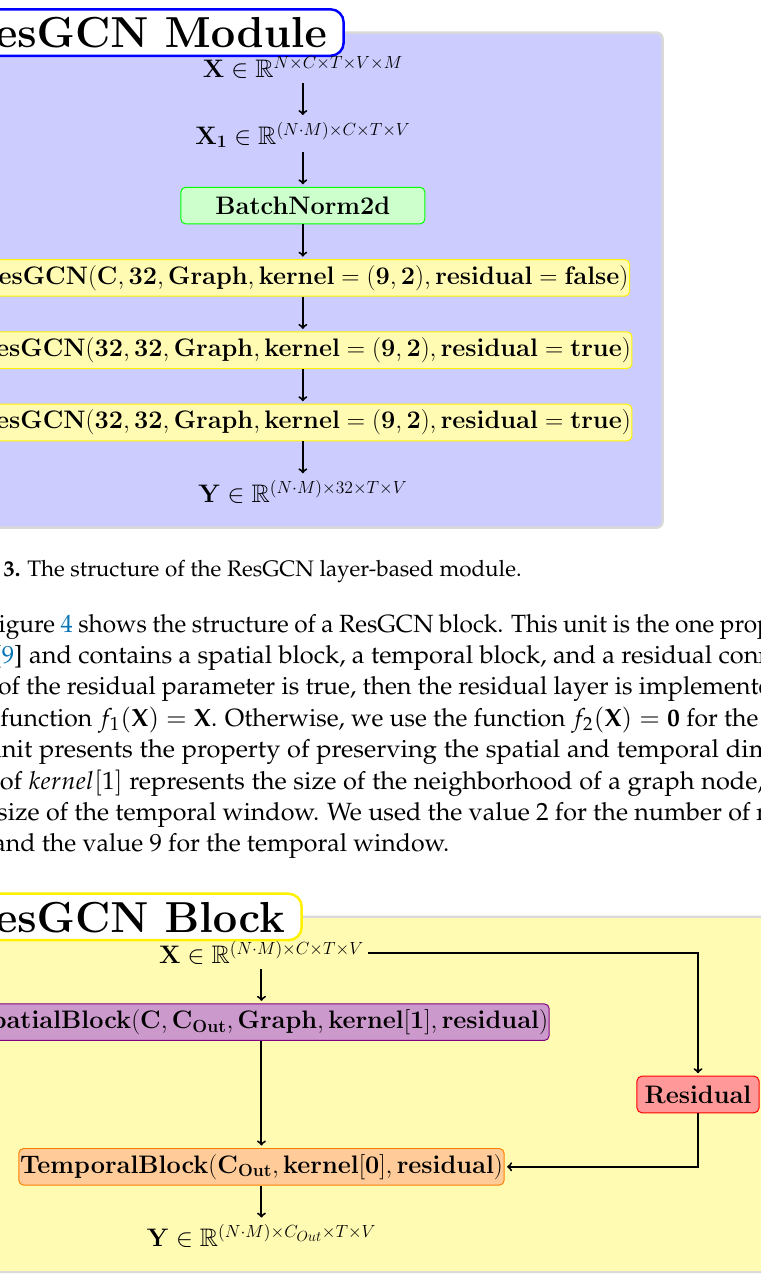
Figure 4. The architecture used for a ResGCN block in which the residual block consists of f 1 ( X ) = X or f 2 ( X ) = 0